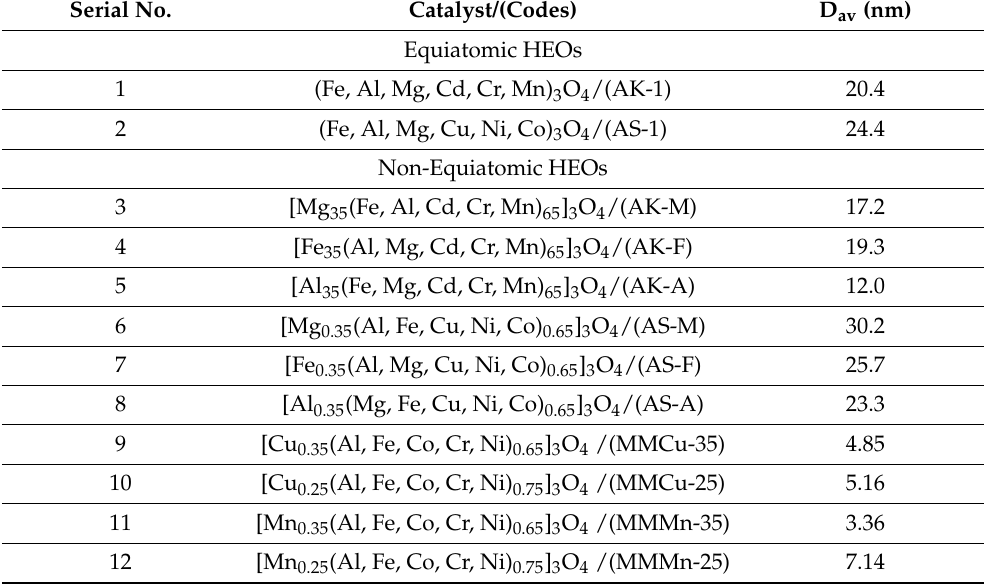
Table 1. Calculated average crystallite sizes of HEOs using Debye–Scherer equation. Serial